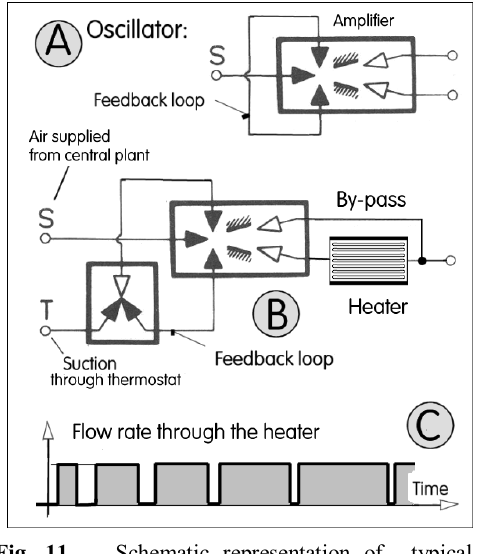
Fig. 11. Schematic representation of typical fluidic oscillator A , and of heater flow control B by the input flow T through the jet pump placed here into the feedback loop. The diagram C shows the resultant pulse-width modulated heater flow.